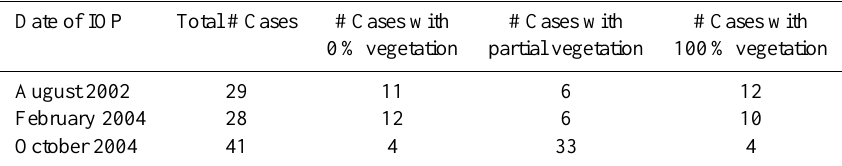
Table 2. Number of cases of each surface type (as identified from current methodology) measured with spectroradiometer for each IOP